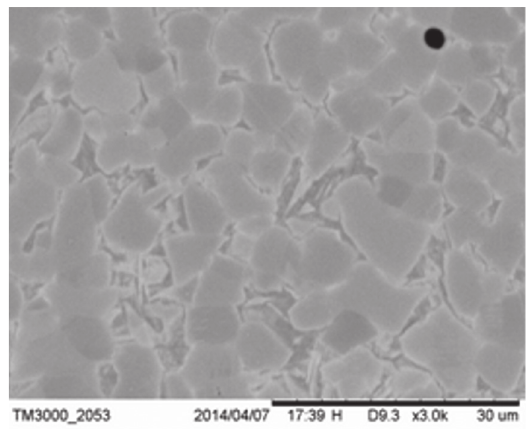
Figure 7: SEM micrographs of the cross section of the cold spray repair.